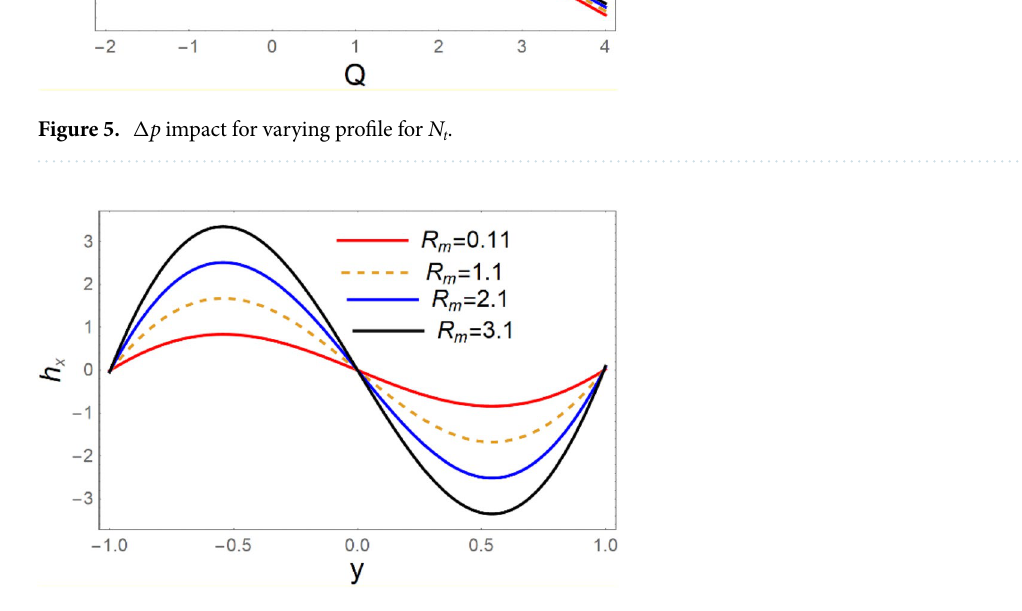
Figure 6. h x variations for R m